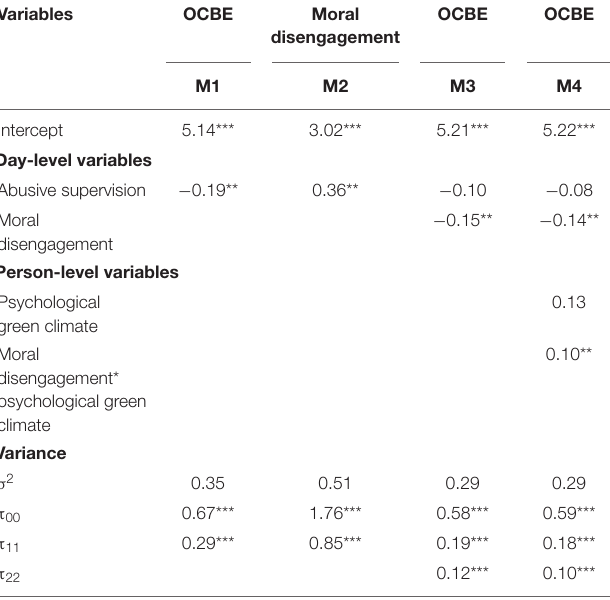
TABLE 2 | HLM results of analyses predicting daily